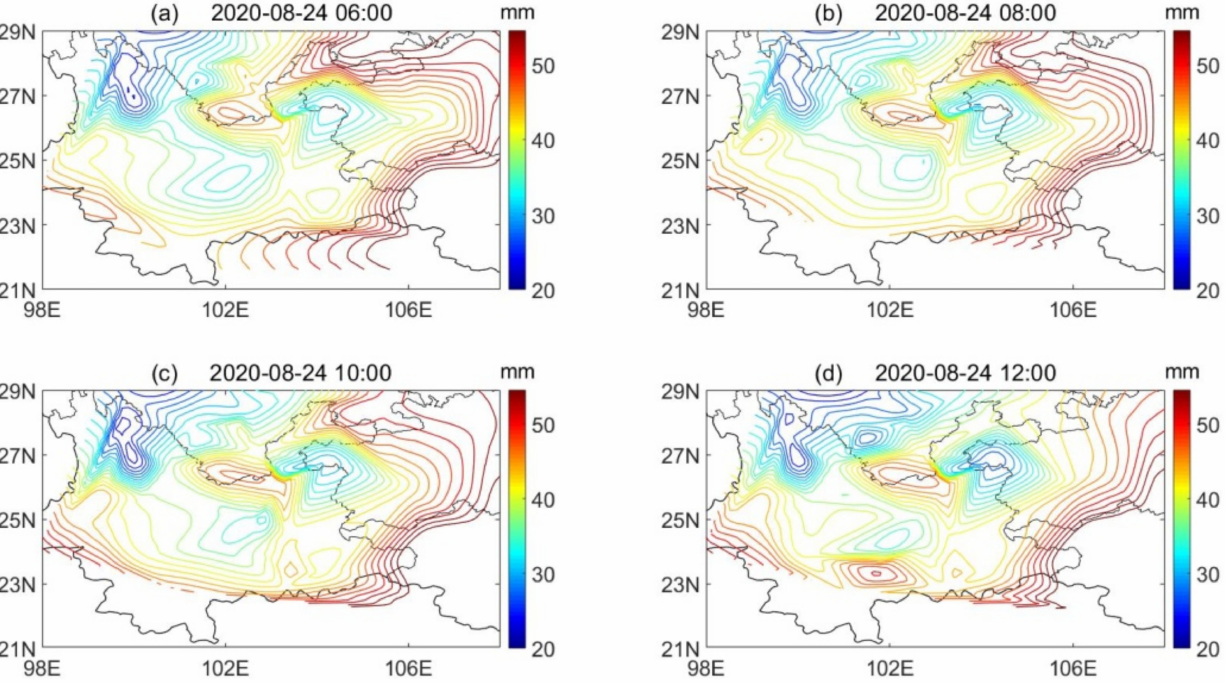
Figure 8. The distribution of PWV from 06:00 (UTC) to 12:00 on 24 August 2020 in Yunnan–Guizhou Plateau (the color scale of the contour represents the PWV, unit: mm. ( a – d ) represent the results of 2 h interval).